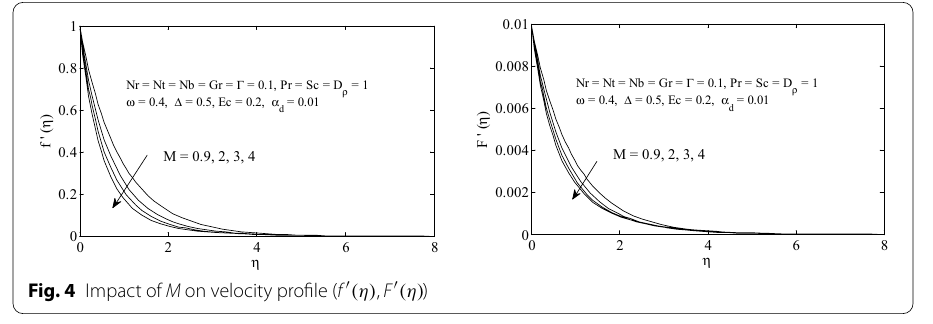
Fig. 4 Impact of M on velocity profile ( f ′ (η) , F ′ (η) )